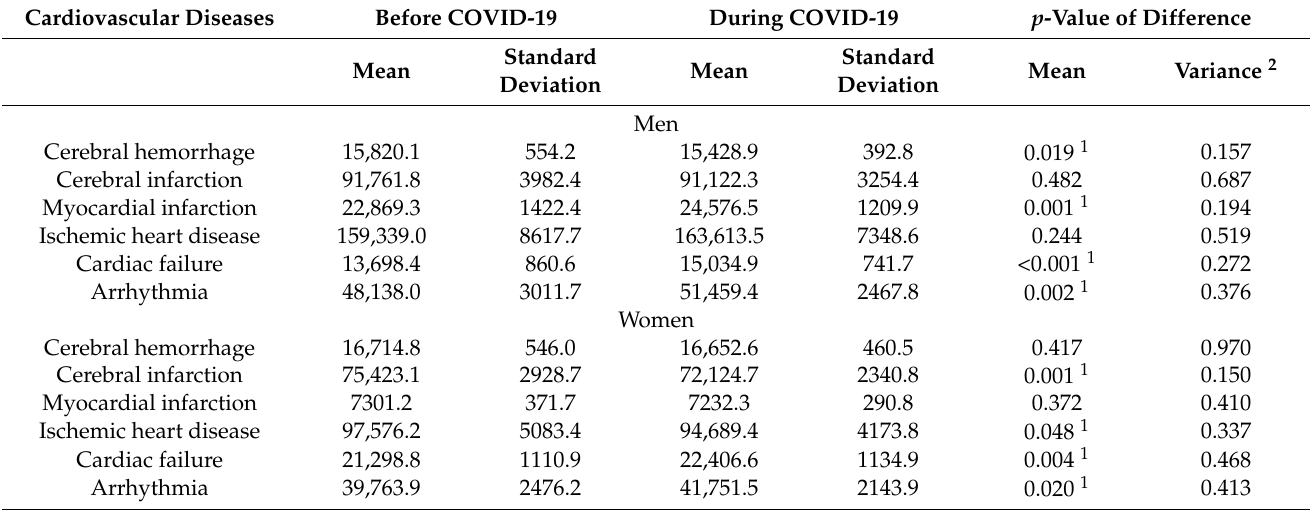
Table 2. Mean and standard deviation of the monthly incidence in six cardiovascular diseases before and during the COVID-19 pandemic stratified by sex in subgroup